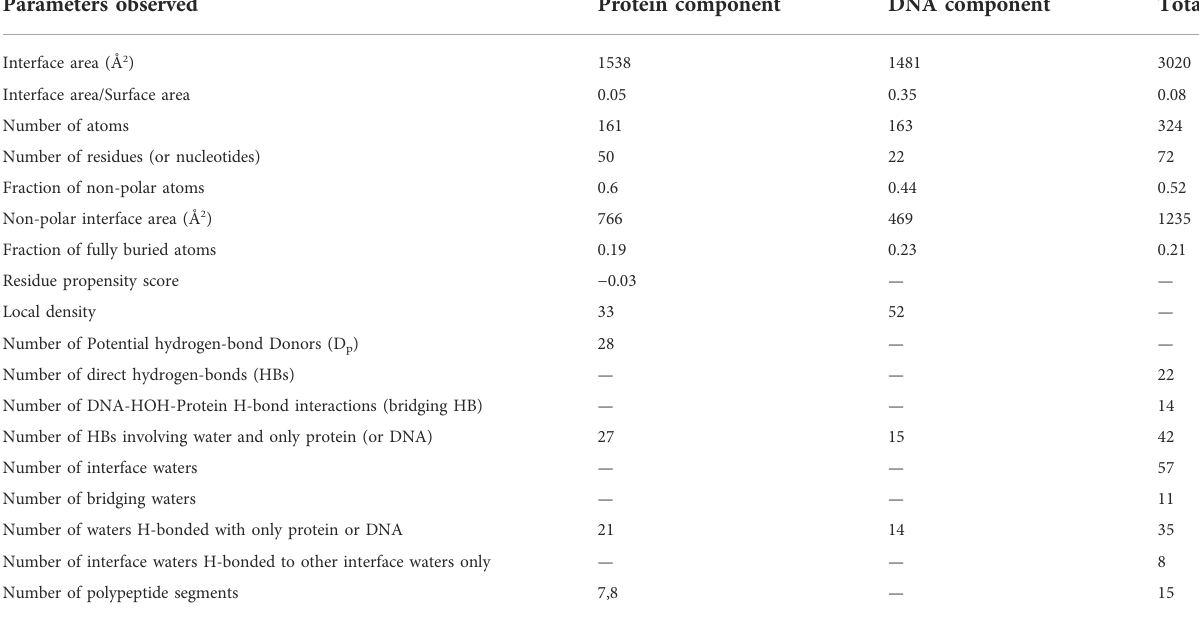
TABLE 1 Parameters for the interface in the human NF-kappaB p52 homodimer-DNA complex (PDB code, 1a3q). Parameters